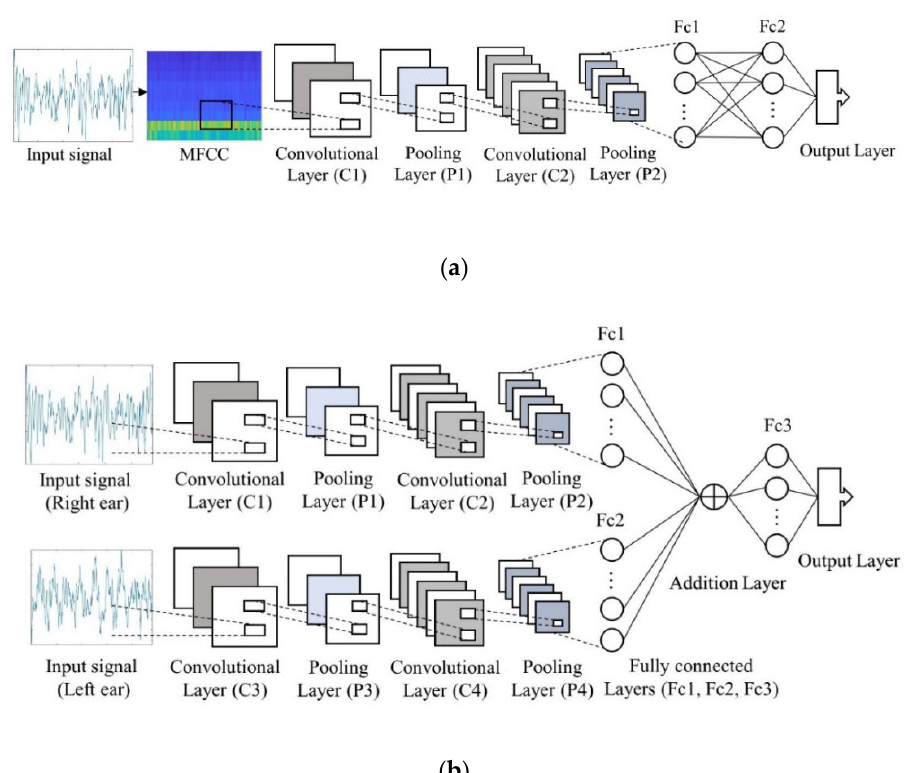
Figure 19. Different sound quality prediction models for comparison: ( a ) Monaural MFCC-CNN model; ( b ) Binaural time series CNN model.